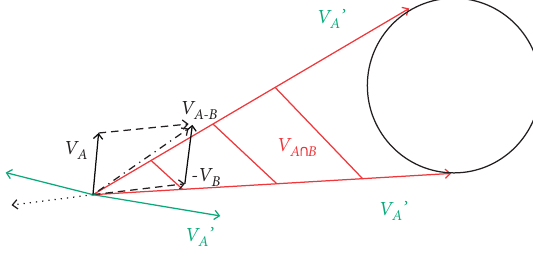
Figure 1: Speed vector synthesis